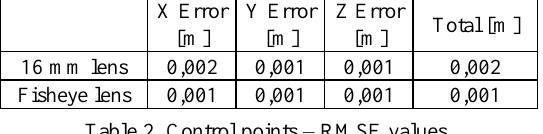
Table 2. Control points – RMSE values.